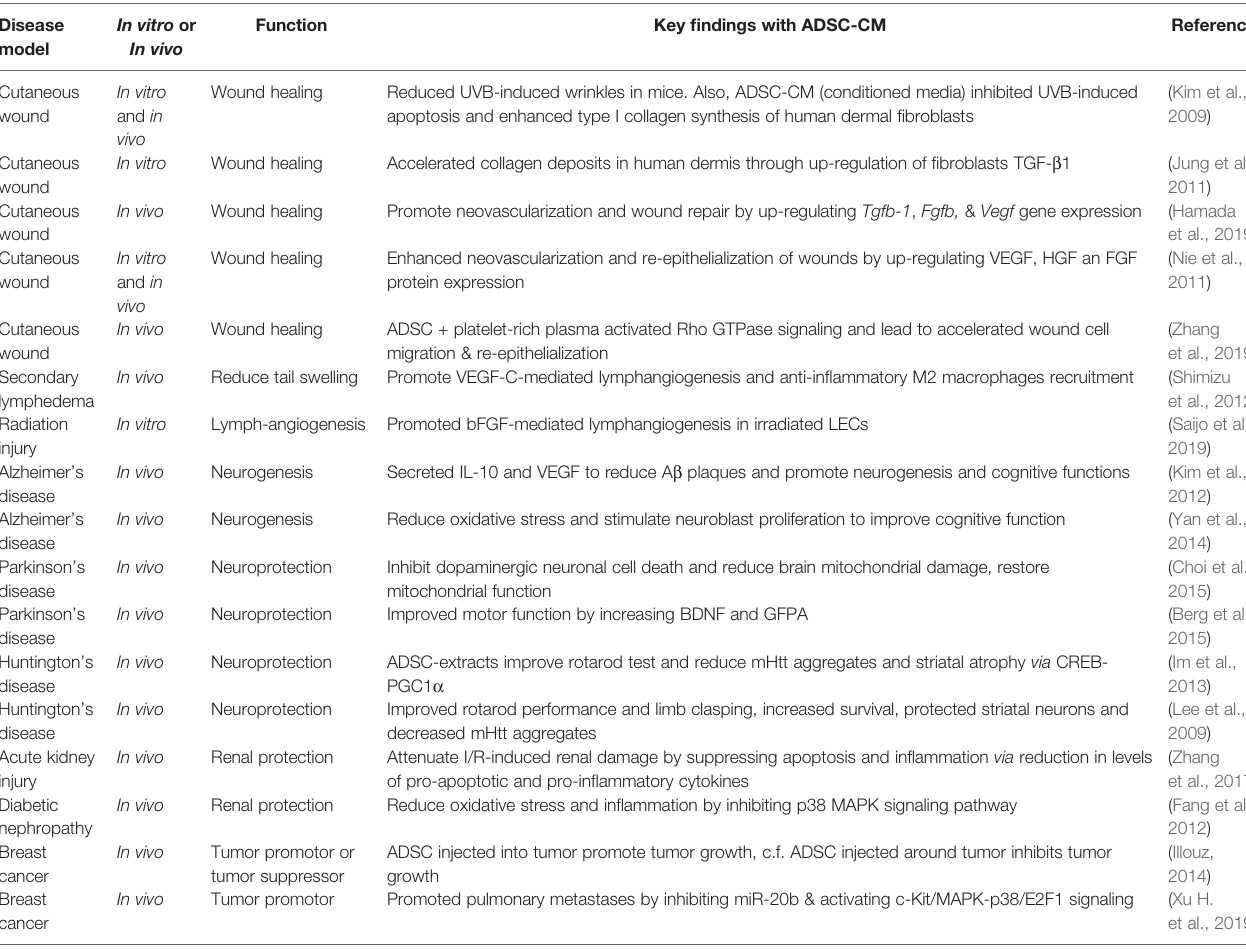
TABLE 1 | Pre-clinical studies of ADSCs. In vitro or Disease Function Key fi ndings with In vivo model